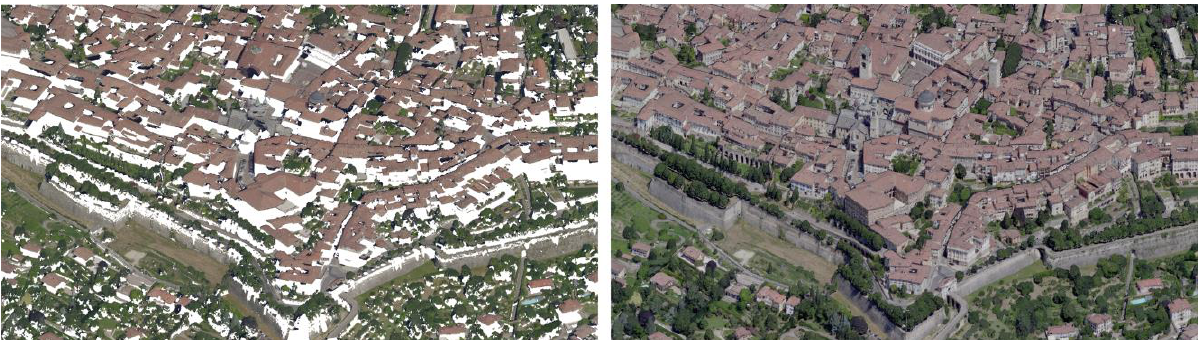
Figure 3. The same part of the historical city seen as 2.5D DSM cloud (left) and 3D point cloud